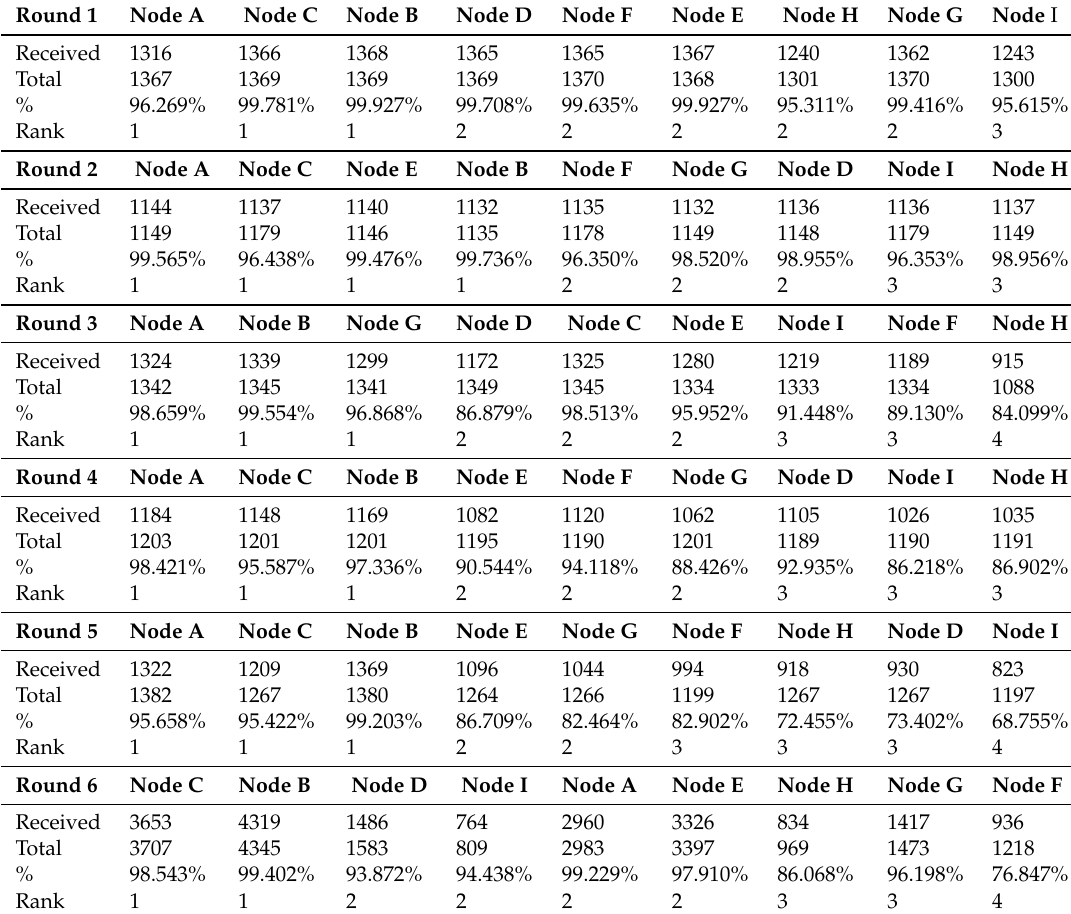
Table 7. Individual node results for each test